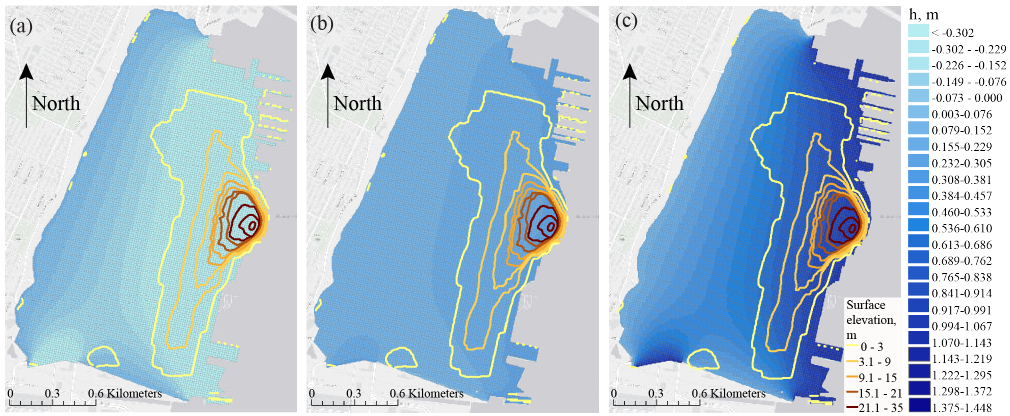
Figure 12. Simulation results of the water table of the unconfined aquifer underneath the City of Hoboken: ( a ) the deepest; ( b ) the average; and ( c ) the shallowest calculated levels with respect to datum.